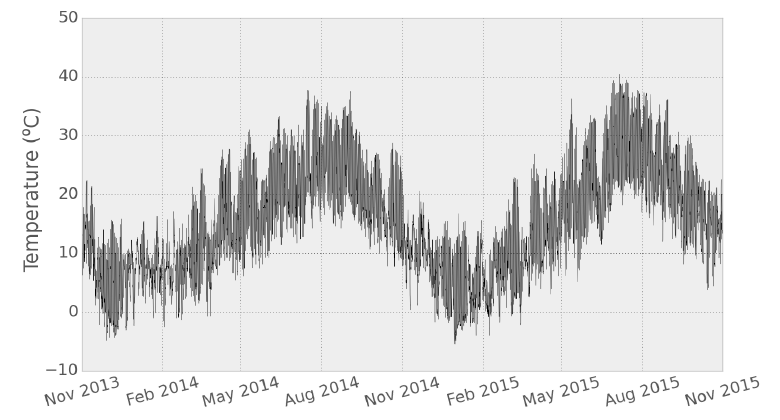
Figure 6. Temperature data in Network